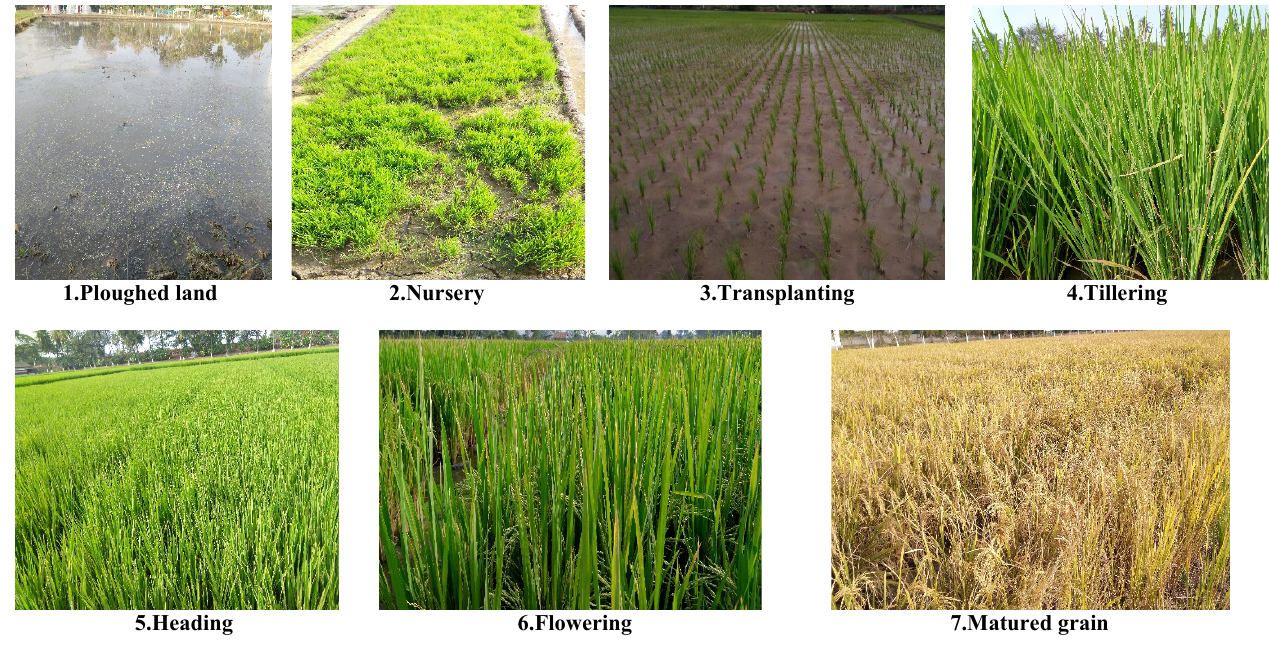
Table 2. Photographs taken at different growth stages of rice